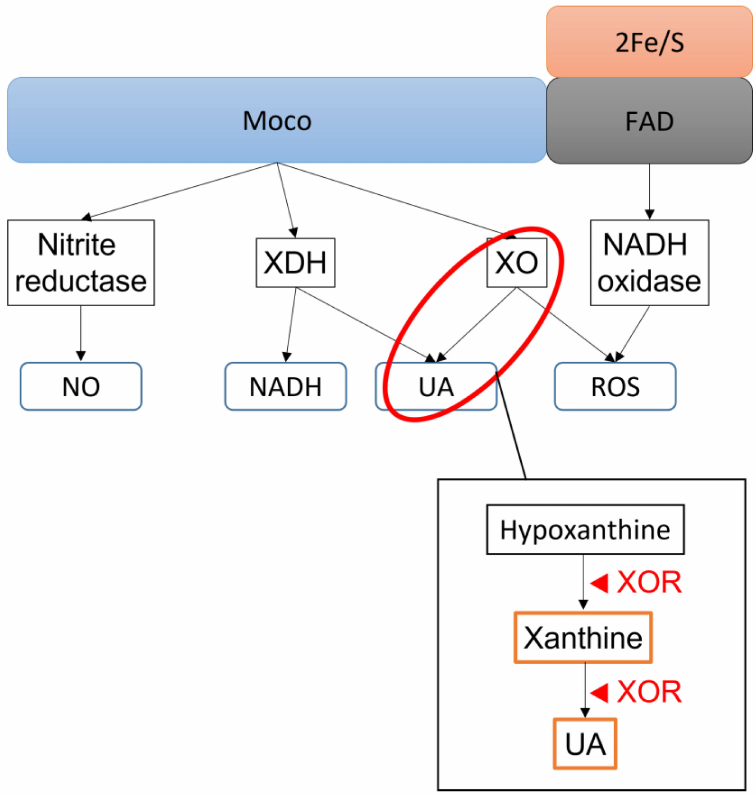
Figure 1. XOR activities and